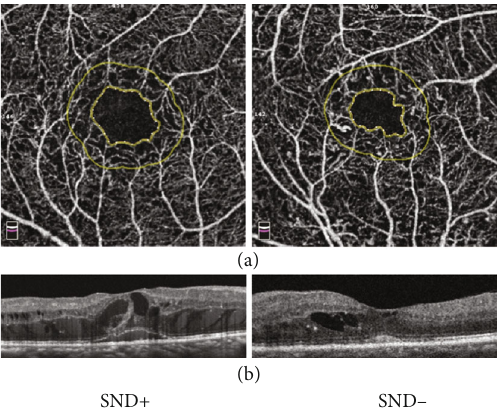
Figure 1: (a) Representative samples of the foveal avascular zone (FAZ) measurements including the area, perimeter, AI, and FD-300 at the foveal avascular zone for the eyes with and without subfoveal neuroretinal detachment (SND). (b) B-scans showing diabetic macular edema with or without SND.